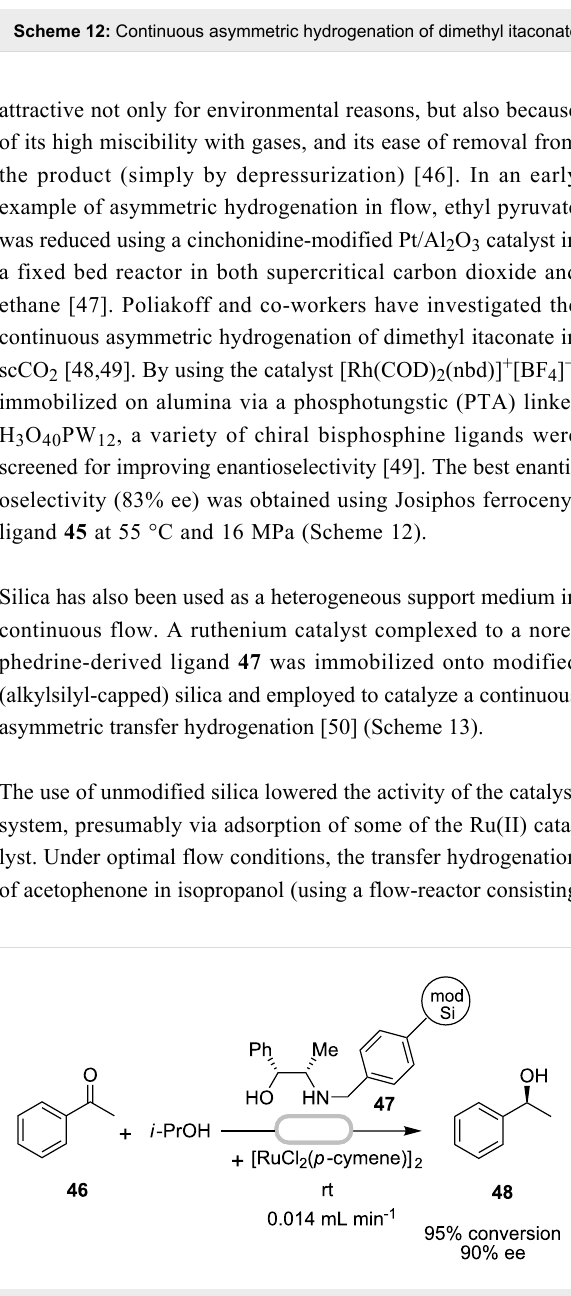
Scheme 13: Continuous asymmetric transfer hydrogenation of acet-